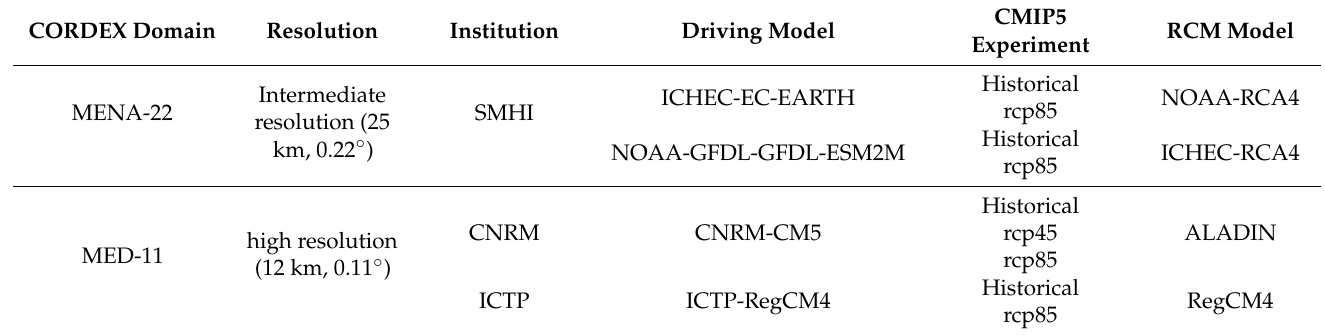
Table 2. Regional climate models (RCMs) used in this